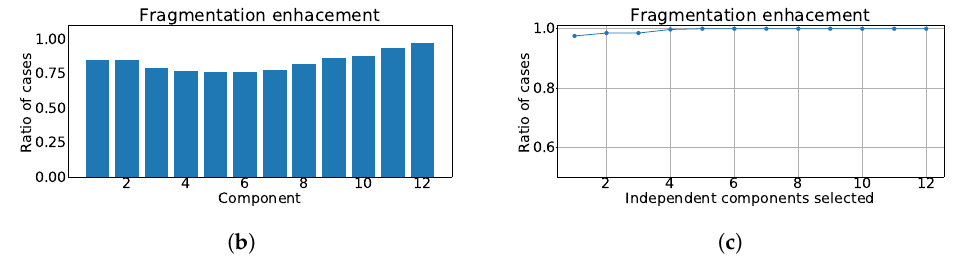
Figure 10. Different measurements for ICA applied over twelve-lead ECG. ( a ) Distribution of ρ RMSE coefficient for each independent component, ρ RMSE values lower than zero represents values of RMSE over ECG greater than values of RMSE over ICA output. ( b ) Ratio of fragmentation wave enhancement for each independent component, ratio of cases where the ρ RMSE coefficient is greater than zeros. ( c ) Cumulative ratio of fragmentation wave enhancement, this ratio is computed by joining the results of isolated independent components.